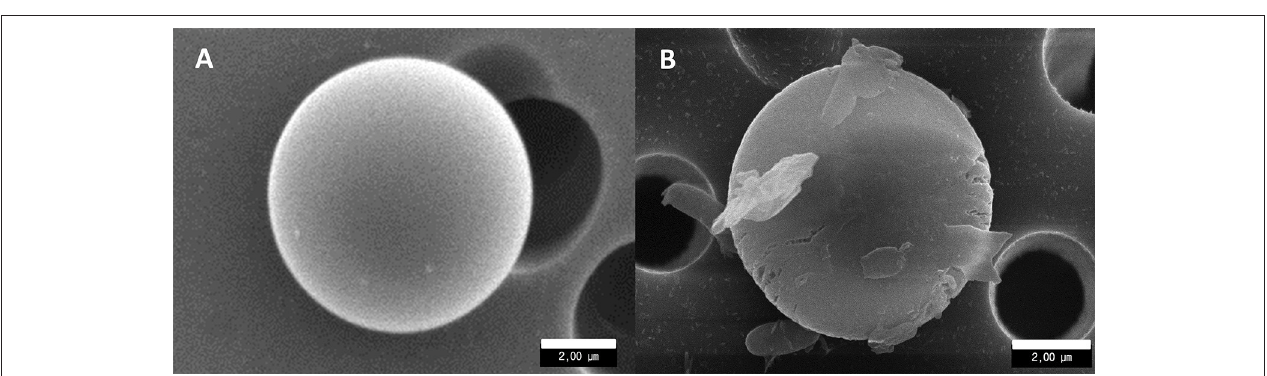
FIGURE 5 | Ways of performing laboratory exposures.